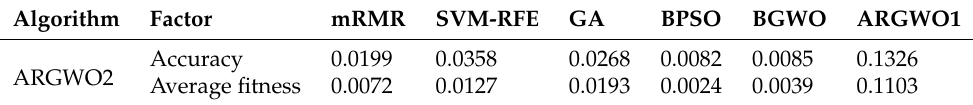
Table 10. p -value between the ARGWO2 and other